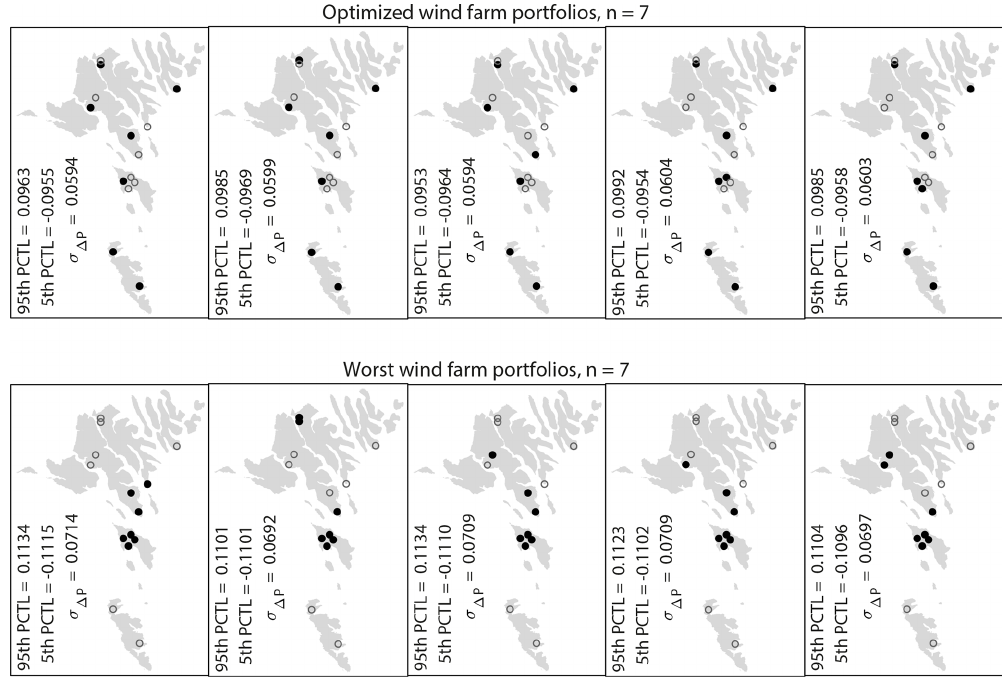
The average squared coherence values for (24h) − 1 < f < (16h) − 1 and (72h) − 1 < f < (48h) − 1 decrease comparably more slowly with respect to inter-site distance, and the values are scattered. The lowest average squared coherence values for (24h) − 1 < f < (16h) − 1 and (72h) − 1 < f < (48h) − 1